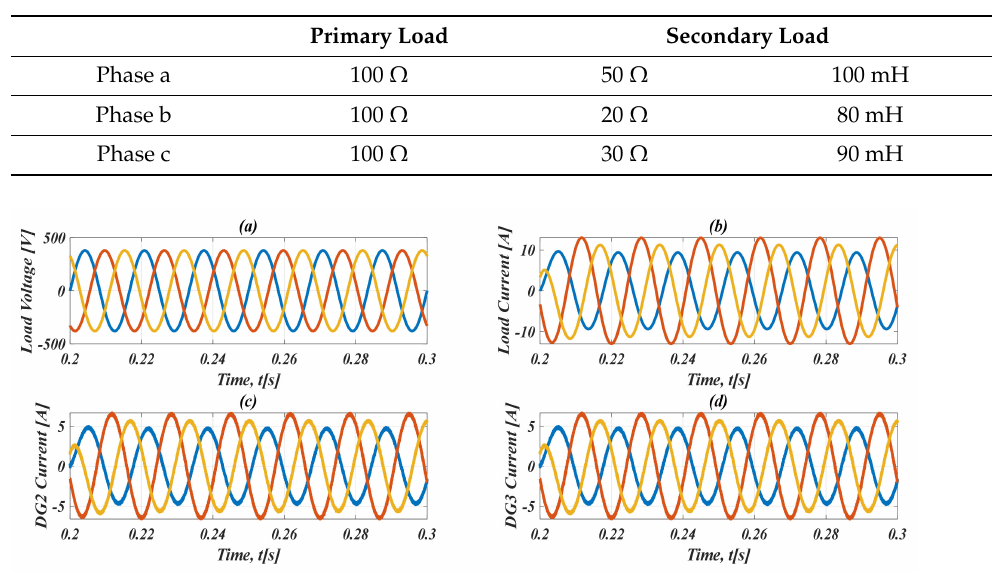
Table 4. Asymmetric Inductive-Resistive Load Parameter.